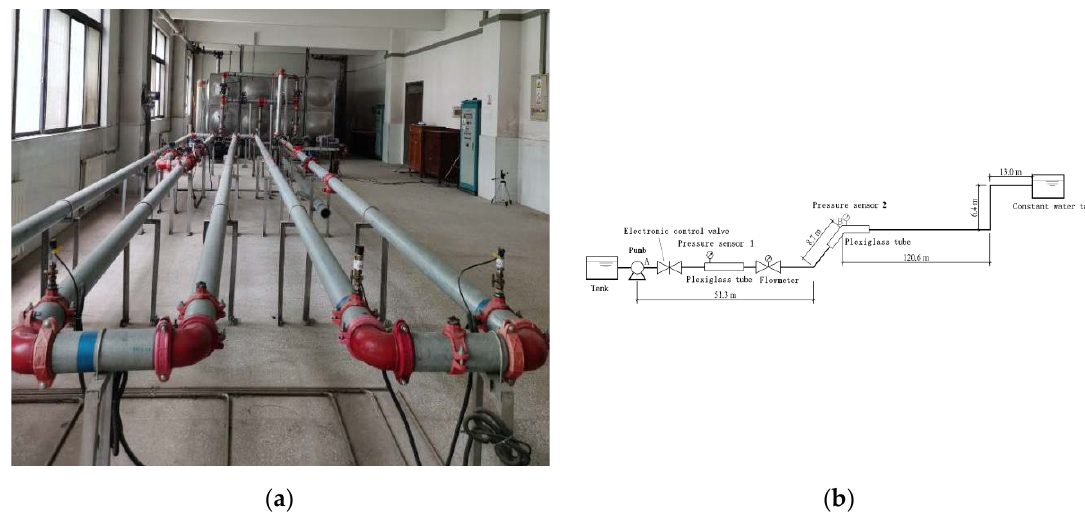
Figure 1. Photo ( a ) and schematic ( b ) of the experimental device.